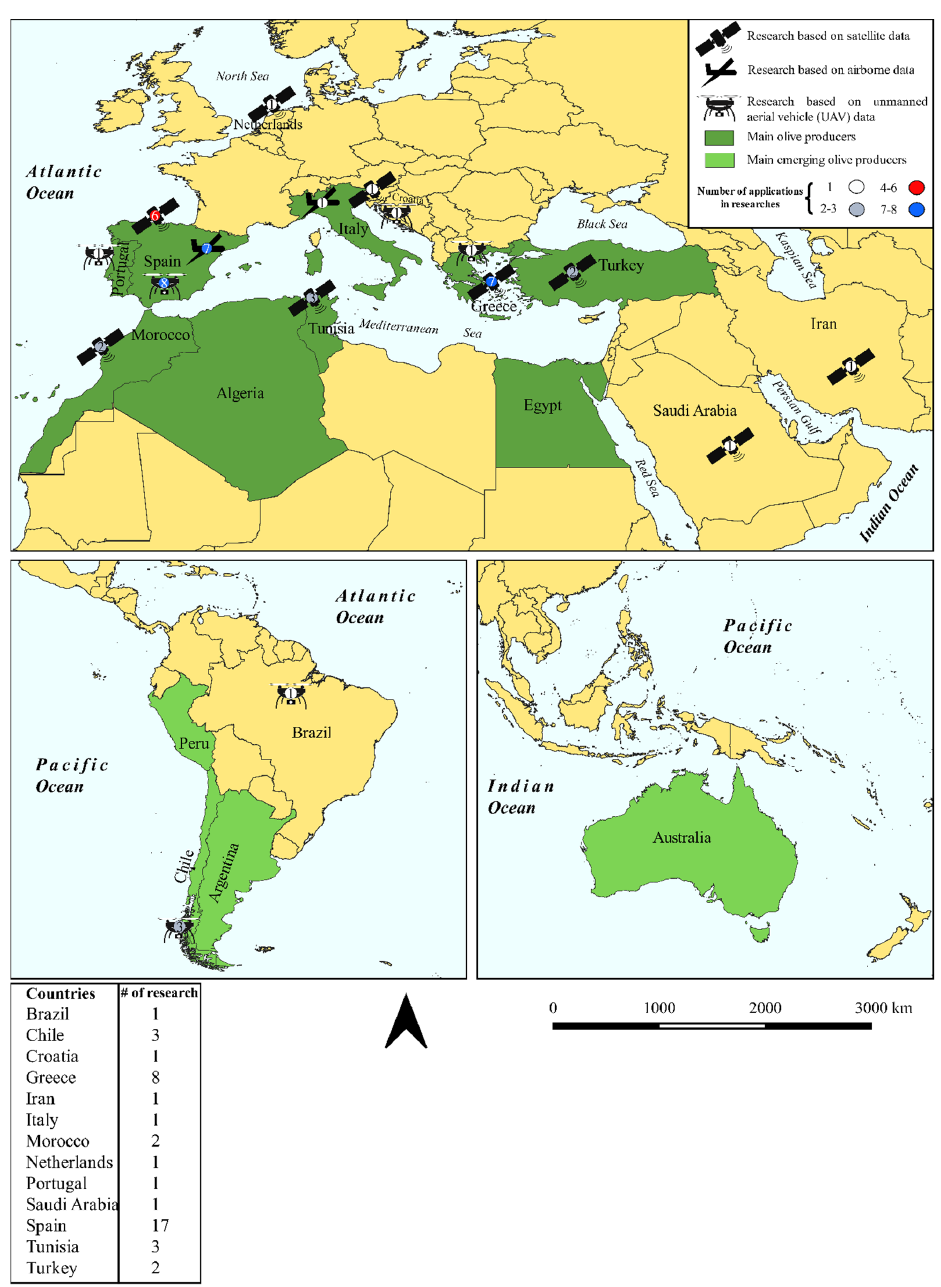
Figure 1. Map showing a comprehensive view of remote sensing (RS) applications distribution, according to the distribution of research study sites in the countries reported in the analyzed papers and the worldwide geographical distribution of olive cultivation. The main olive-producer countries are highlighted in dark green, while the main emerging-producer countries are highlighted in light green. The symbols of different color (shown in the upper right) distinguish the type of remote sensing platform (satellite, airborne, or unmanned aerial vehicle) used in the research and the number of research performed from 2000 to the end of March 2022. The table at the bottom left shows the number of remote sensing researches in olive growing carried out in each country. Important to consider that some researches include more than one RS platform.